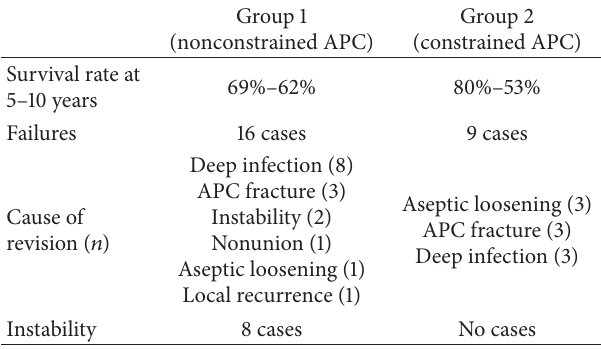
Table 2: Comparison of the results between groups.